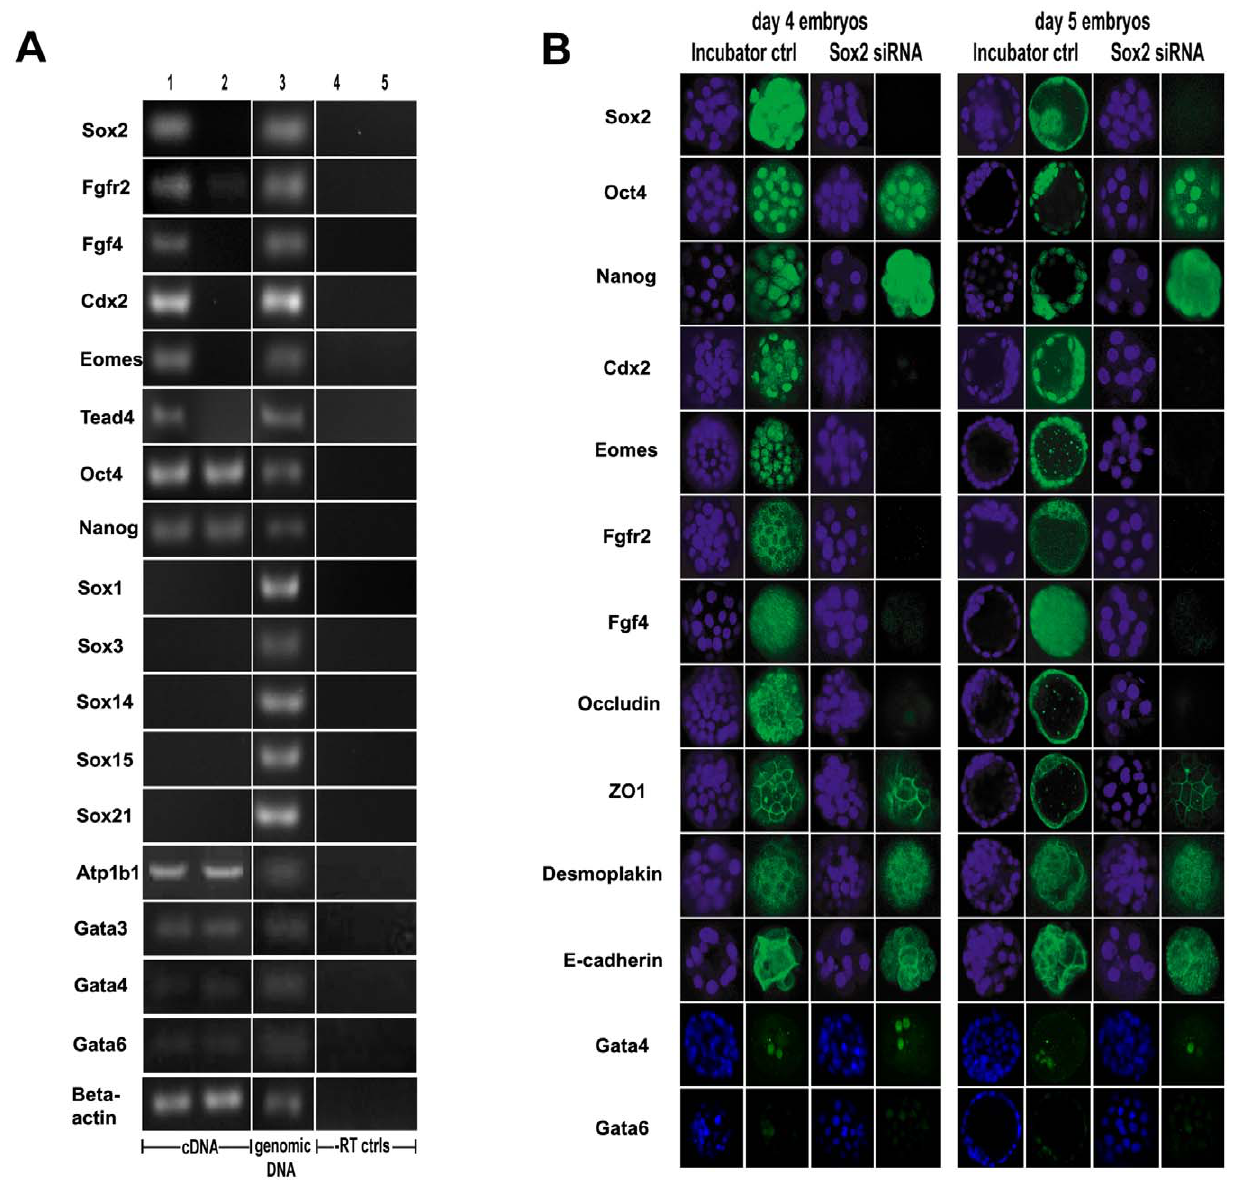
Figure 4. Assessment of ICM and TE markers in Sox2 -siRNA and control MF1 x CD1 embryos. ( A ) RT-PCR for Sox2 , Fgfr2 , Fgf4 , Cdx2 , Eomes , Tead4 , Oct4 , Nanog , Sox1 , Sox3 , Sox14 , Sox15 , Sox21 and beta-actin (40 cycles) on day 4: incubator-control embryos (lane 1); Sox2 -duplex-2-siRNA embryos (lane 2); genomic DNA (lane 3); incubator-control morulae –RT (lane 4); Sox2- duplex-2-siRNA morulae –RT (lane 5). In the absence of Sox2 transcript after siRNA, a clear reduction of Fgfr2 , Ffg4 , Cdx2, Eomes and Tead4 transcripts in Sox2 -siRNA embryos was observed. Oct4 and Nanog transcripts were unaffected in Sox2 knock-down morulae compared to incubator-control morulae. To ensure absence of signal did not reflect low detectable message, we performed PCR at 40 cycles. PCR for all transcripts was determined at 25, 30 and 35 cycles with results similar to those presented, but with weaker band intensity where present. Sox1 , Sox3 , Sox14 , Sox15 and Sox21 transcripts were not detected in incubator-control morulae or Sox2 knock-down morulae. Atp1b1 (ATPase, Na + /K + transporting, beta 1 polypeptide), Gata3 , Gata4 and Gata6 transcripts were detected in comparable levels in Sox2 knock-down morulae compared to incubator-control morulae. Beta-actin transcripts were detected in both Sox2- siRNA and incubator-control embryos. This figure illustrates Sox2 -duplex-2-siRNA embryo transcripts, whereas similar patterns of transcript expression for Sox2 -siRNA duplexes -1 and -3 are shown in Figure S4. ( B ) Comparison of Sox2 knock-down embryos (as assessed by absence of fluorescence after Sox2 staining) with incubator (untreated) control embryos for ICM and TE markers. Immunofluorescence for Sox2 (Abcam), Oct4, Nanog, Cdx2 (rabbit polyclonal from Jane Collins), Eomes, Fgfr2, Fgf4, Occludin, ZO1, Desmoplakin, E-cadherin, Gata4 and Gata6 to compare protein expression between incubator control and Sox2 -siRNA embryos at day 4 and 5 of preimplantation development. The images are single optical sections from confocal Z- series. Sox2 -duplex-1-siRNA embryos stained for Sox2 are shown in this Figure. In all cases, after knock-down with each of the three duplexes, Sox2 siRNA embryos were negative for Sox2. For assessment of the other markers, embryos from all three knock-down construct groups were pooled. A large reduction in Sox2, Cdx2, Eomes, Fgfr2, Fgf4 and Occludin protein was observed, whereas Oct4, Nanog, ZO1, Desmoplakin, E-cadherin, Gata4 and Gata6 remained unaffected. However, Nanog staining appeared more cytoplasmic in Sox2 knock-down embryos. The selected image for the day 4 incubator control embryo stained for Cdx2, is a plane through the top of the embryo and the positively stained Cdx2 cell in the center is located in the outer layer of the embryo. The staining patterns for Sox2 and Cdx2 were confirmed with different Sox2 (Chemicon) and Cdx2 (Biogenex) antibodies (Figure S3). At least 10 embryos were stained for each antigen and representative embryos are shown. Blue indicates DAPI stained nuclei and green staining for the protein of interest. In all cases immunological controls were negative (Figure S6). Where antibodies were compatible, embryos were double-stained for two markers. In all cases the anti-Sox2 staining for Sox2 -siRNA embryos was negative. Bar: 50 m m. doi:10.1371/journal.pone.0013952.g004 PLoS ONE |